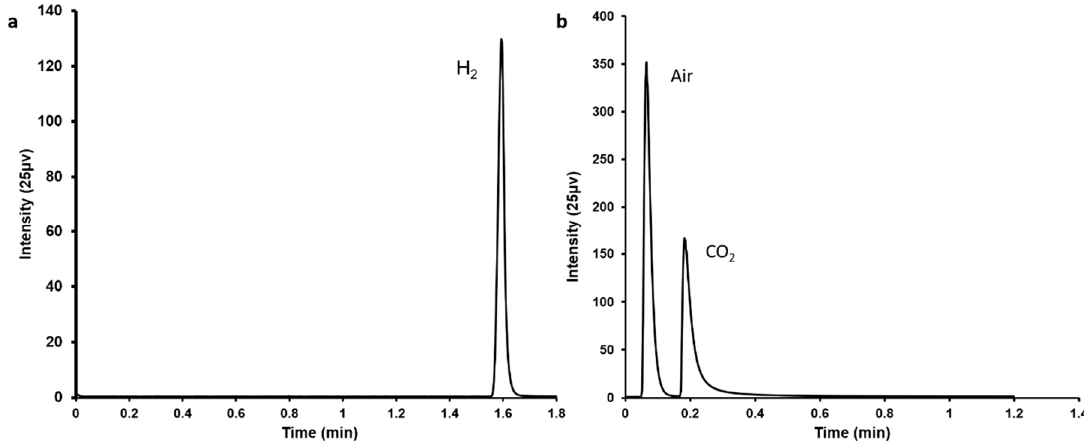
Figure 1. Gas chromatography profiles showing the generation of ( a ) H 2 and ( b ) CO 2 following FA decomposition using Pd / C catalyst.